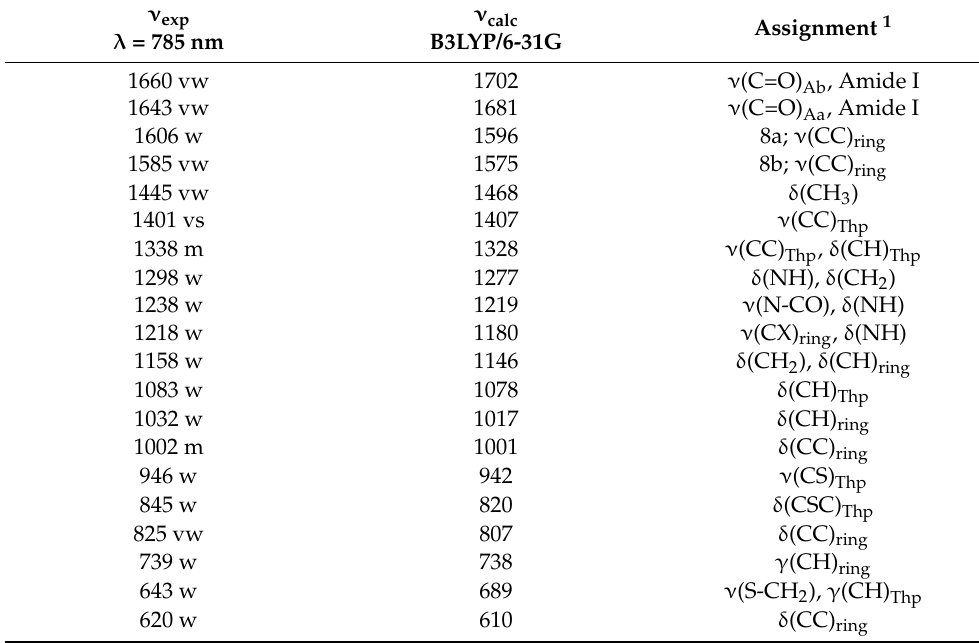
Table 1. Wavenumbers (cm − 1 ) of the main experimental and calculated Raman bands of BB-94 and proposed assignments. ν exp ν calc Assignment 1 λ = 785 nm B3LYP/6-31G 1660 vw 1702 ν (C=O) Ab , Amide I 1643 vw 1681 ν (C=O) Aa , Amide I 1606 w 1596 8a; ν (CC) ring